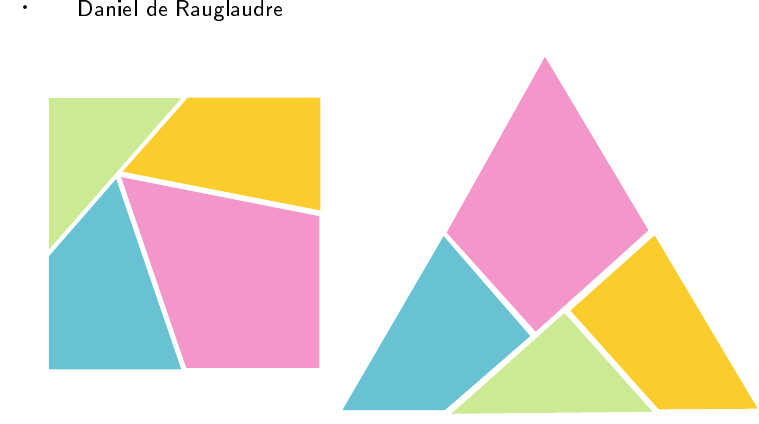
Fig. 1. Equidecomposability (image